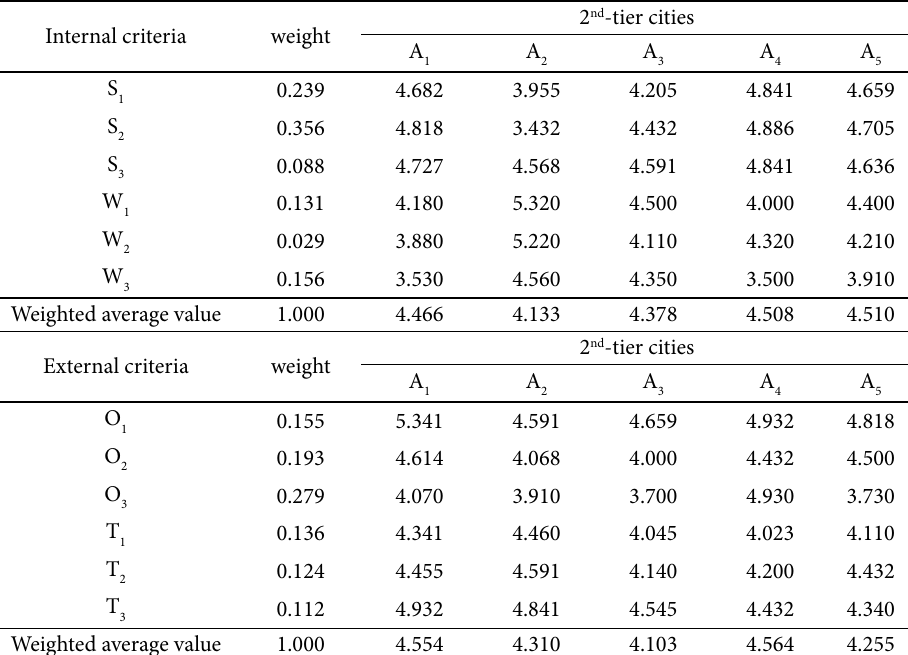
Table 12. Internal and external criteria weighted average score of 2 nd -tier cities in China Internal criteria